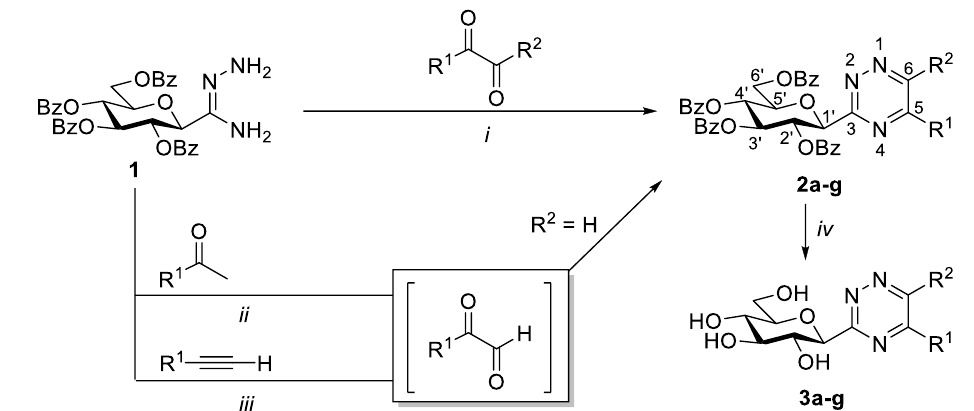
Table 1. Synthesis of 3- (β - D -glucopyranosyl)-1,2,4-triazines.